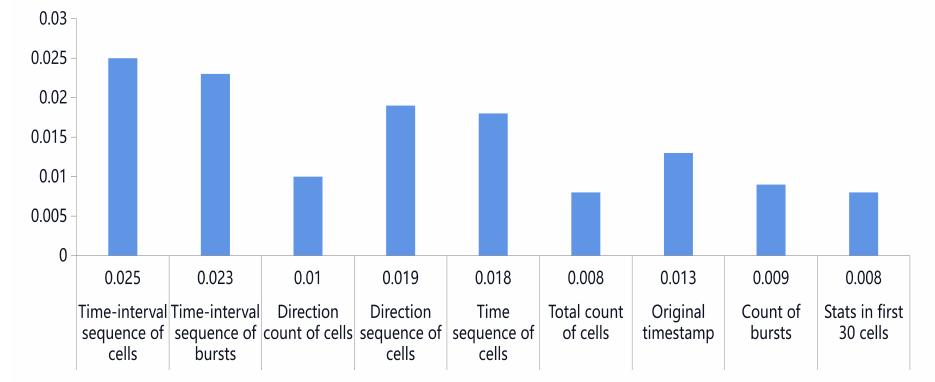
Figure 6. Scores of the top nine features.